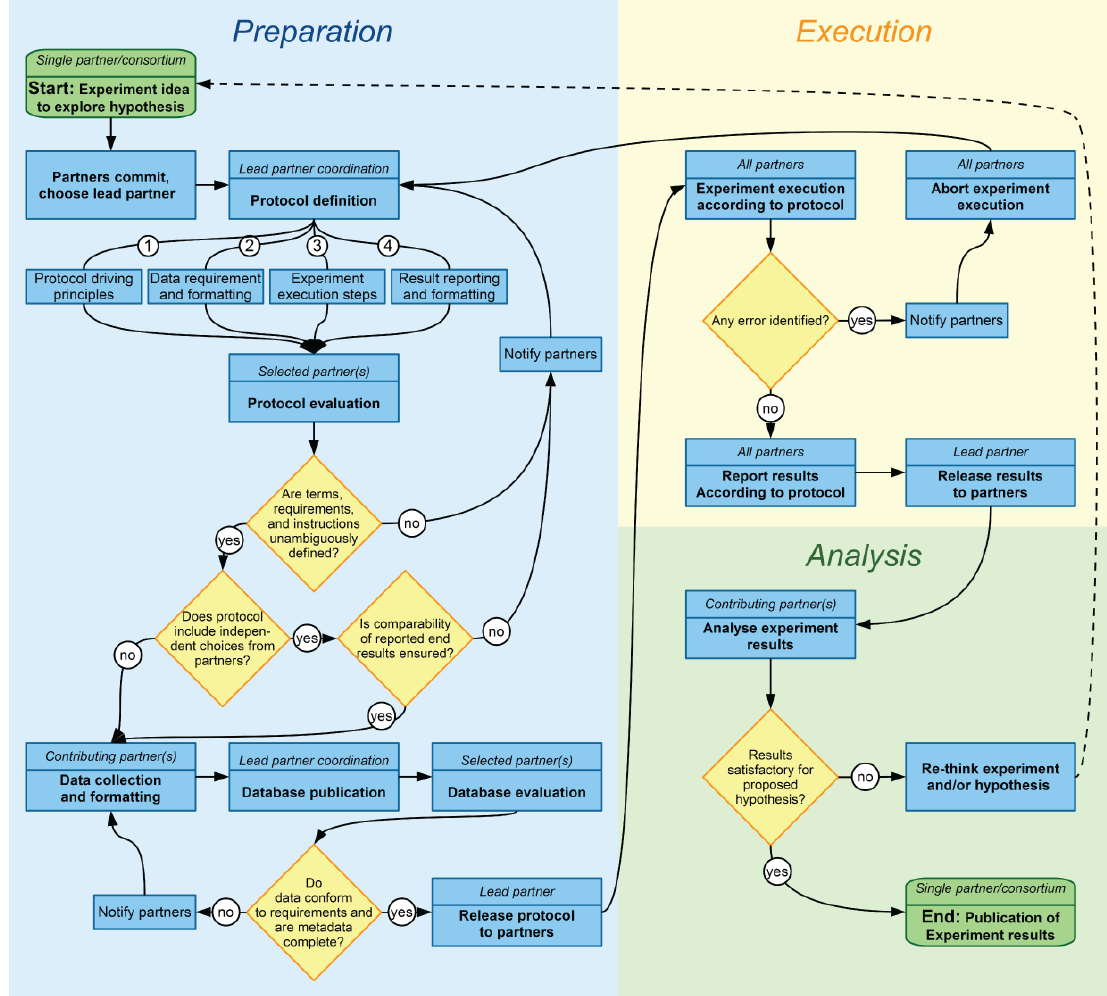
Figure 5. Flowchart of the suggested procedure to establish protocols for collaborative